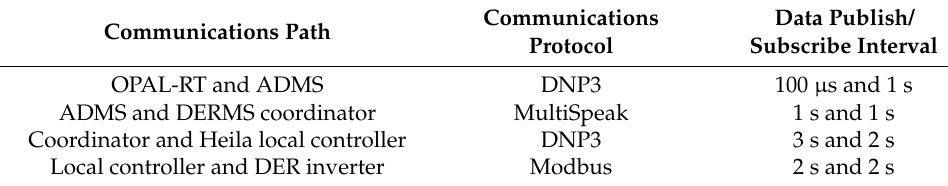
Table 2. Communications in HIL